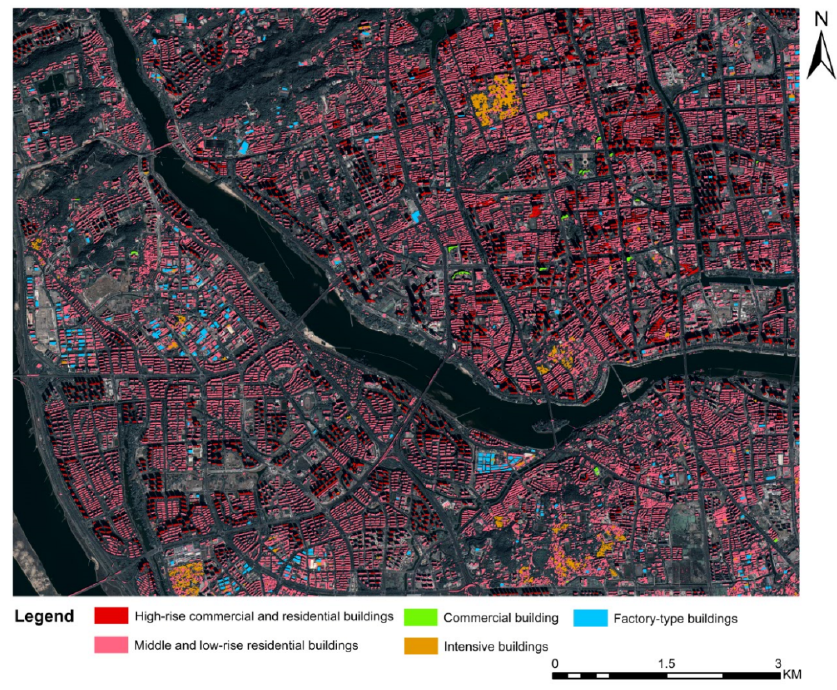
Figure 10. Building type classification results of the study